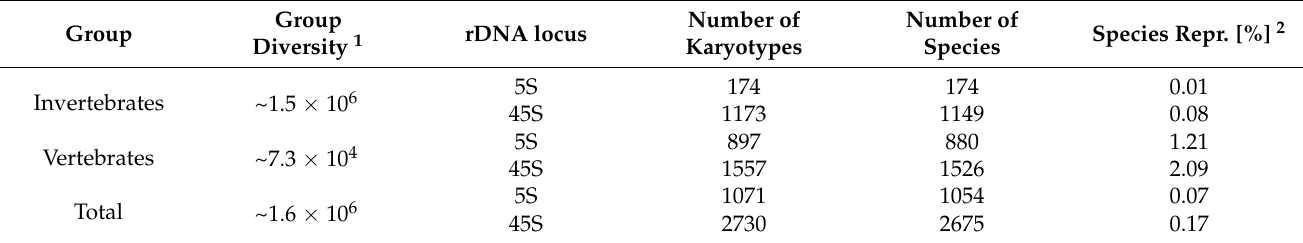
Figure 1. Increased amount of literature in the current version of the animal rDNA loci database. Table 1. Amount of cytogenetic data for 5S and 45S rDNA loci in the database and their relationship to each group’s diversity.